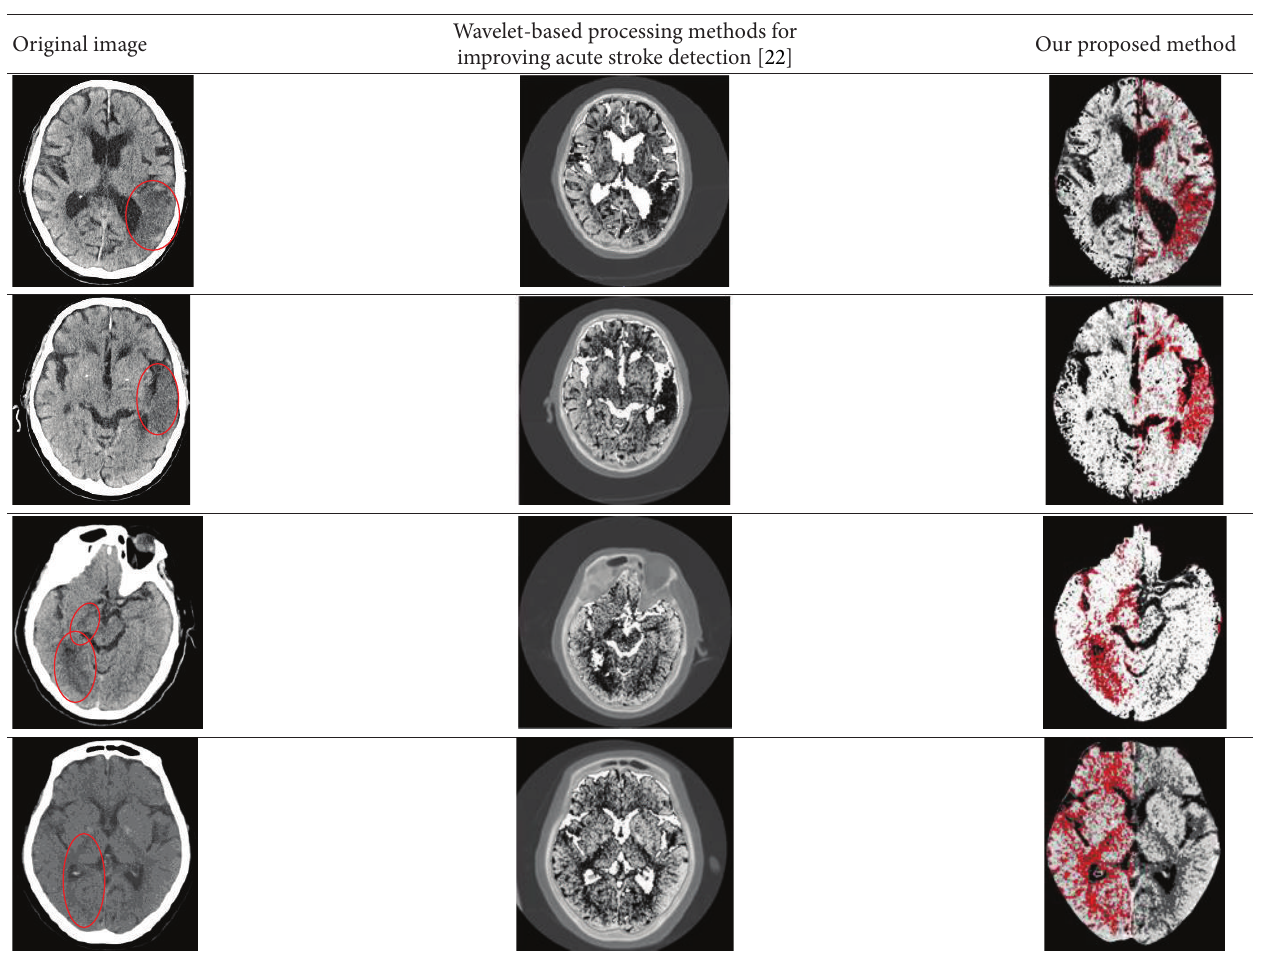
Table 2: Images from successful testing (left-to-right): original image, wavelet-based processing method for improved acute stroke detection, and increased visual perception brain stroke detection